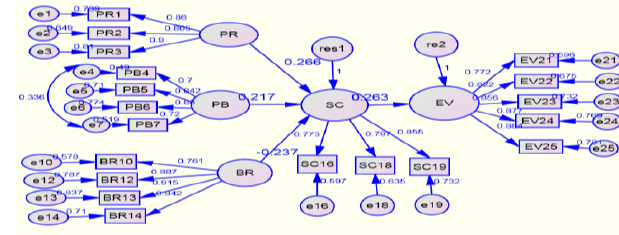
Figure 3: Structural equation